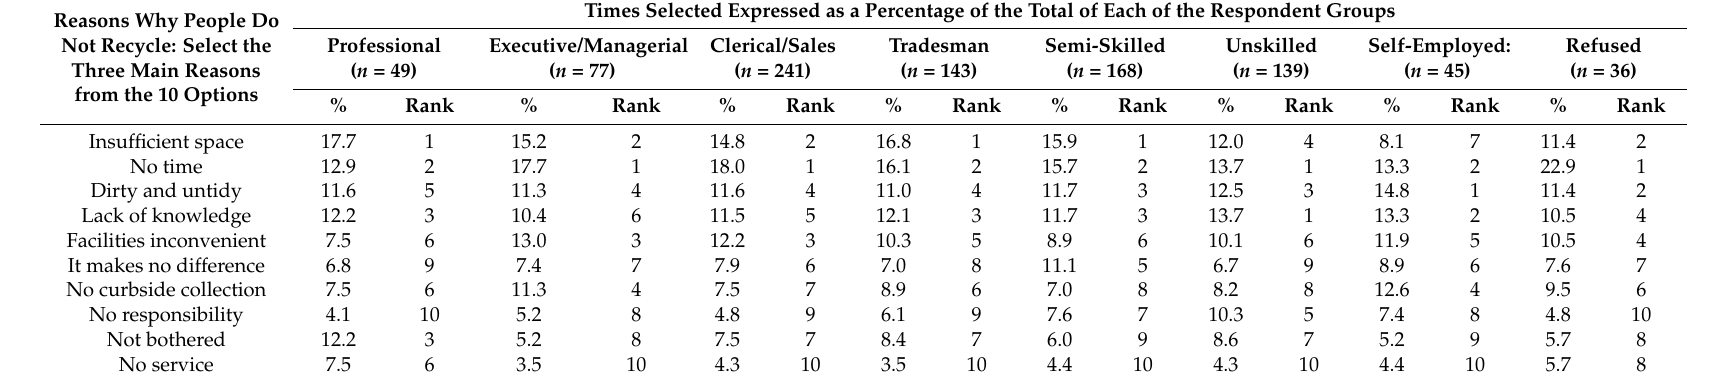
Table A9. Reasons why people do not recycle as enumerated per occupation group ( n = 898)